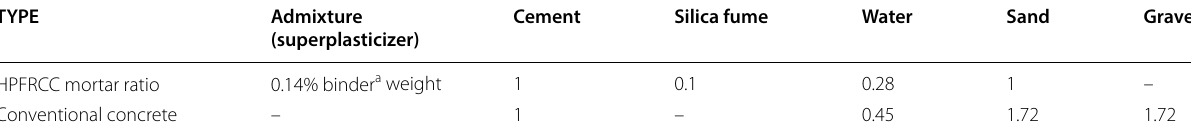
Table 1 Mix design for HPFRCC mortar and normal